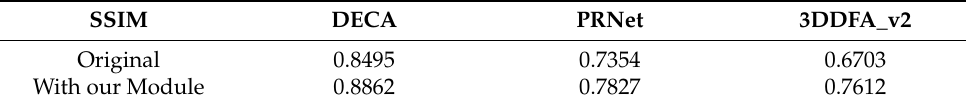
Table 3. SSIM comparison